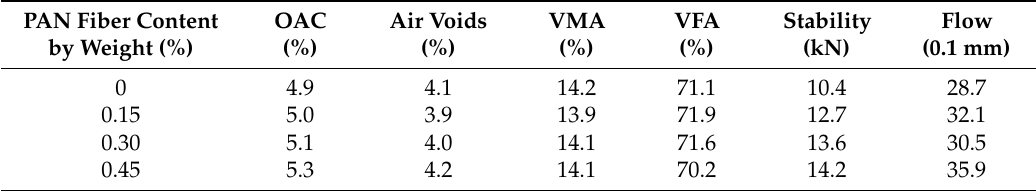
Table 4. Results of all of AC-16 mixtures at the optimum asphalt content (OAC) based on the Marshall method.